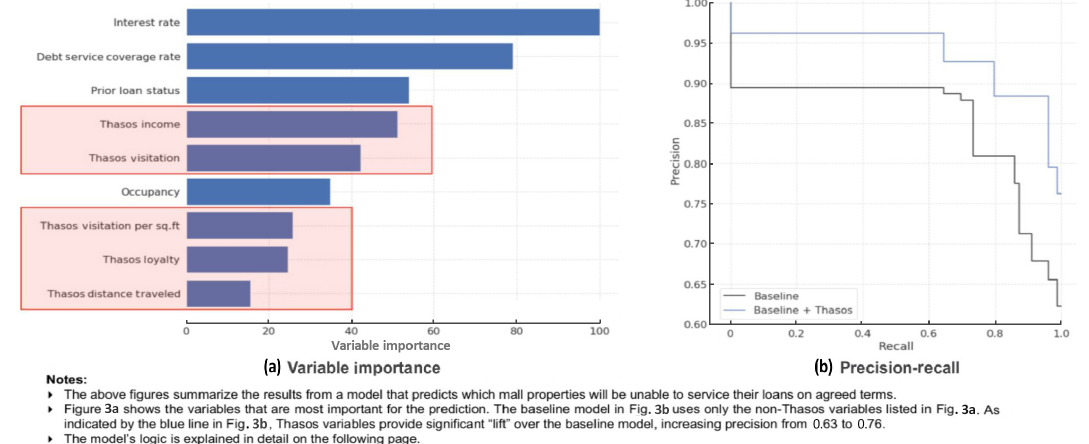
Fig. 3 Pattern of visitation predicts financial viability of stores (from Bloomberg April 15,